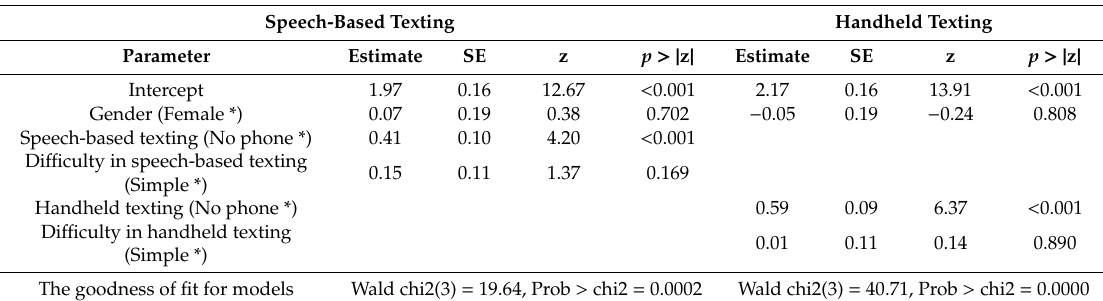
Table 2. Results of the Generalized Estimating Equation (GEE) models for time headway at lead vehicle (LV) brake onset in di ff erent driving